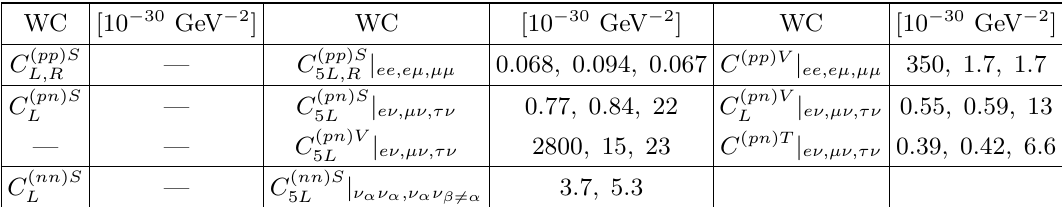
Table 3 . The upper limit on the Wilson coefficients (WC) of the dim-6 hadronic operators